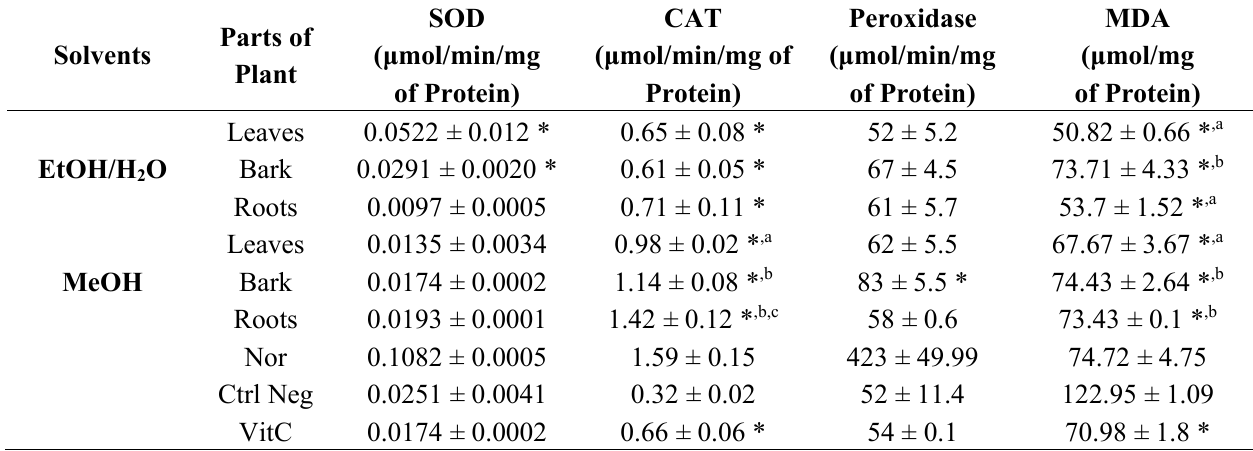
Table 7. Variation of markers involved in oxidative